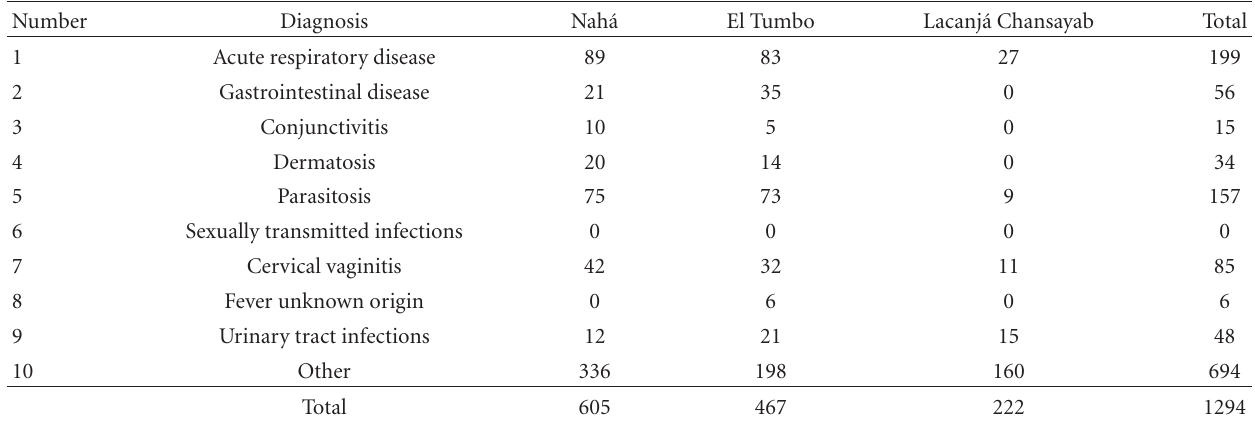
Table 1: Main ten causes of medical attention during the